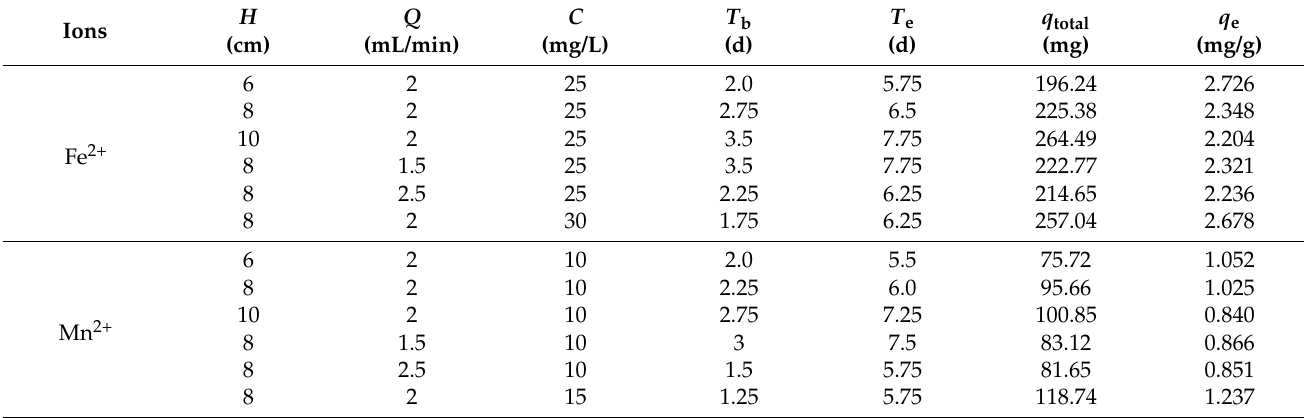
Figure 7. Breakthrough curves for different filler bed heights. Table 2. Adsorption parameters of IHA/TM at different influencing factors.